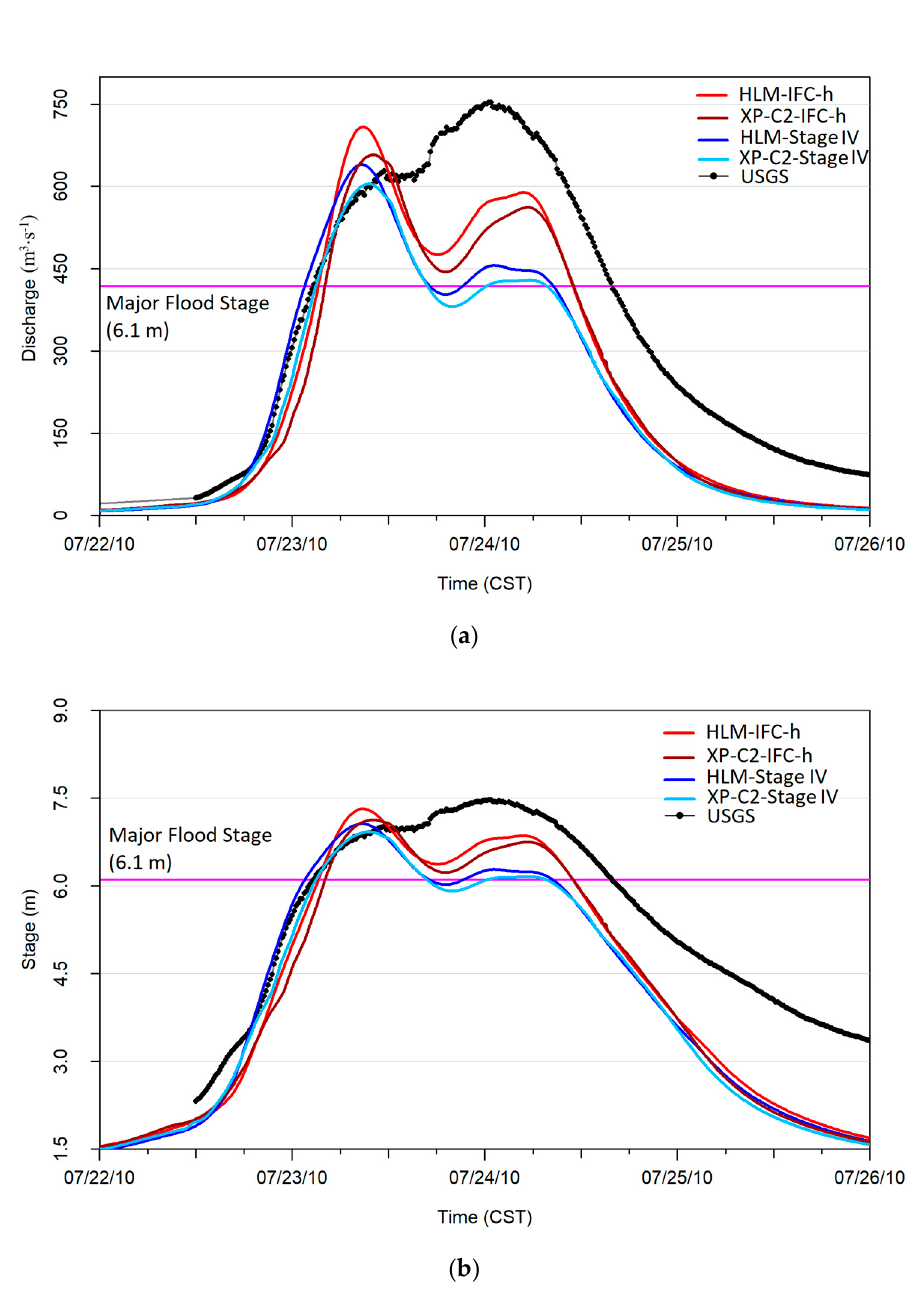
Figure 5. The modeled discharge (m 3 ⋅ s − 1 ) and stage (m) compared to ( a ) USGS stage and ( b ) discharge observations for July 2010. The simulated hydrographs are named according to the model (HLM or XP-C2) and the radar rainfall input. The models forced with the IFC hourly radar rainfall product are red (simulations HLM—FC—h and XP—C2—IFC—h) while those forced with Stage IV hourly radar rainfall are blue (simulations HLM—Stage IV and XP—C2—Stage IV).